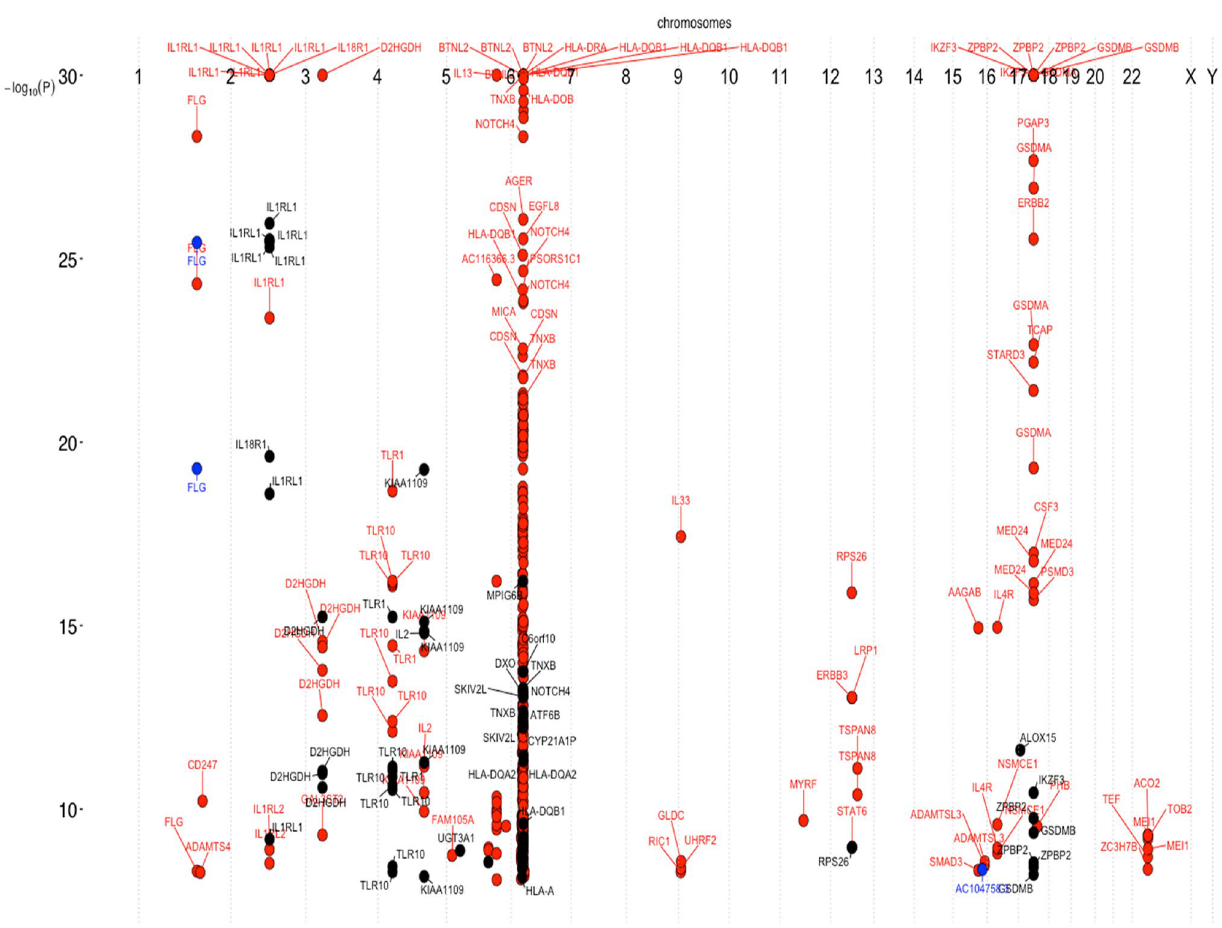
Figure 1. Exon variants of interest (N = 354) significantly associated with asthma, allergic rhinitis or atopic dermatitis in the 450 K UK Biobank samples. The plot shows significance using a threshold of P ≤ 2 × 10 –9 versus chromosomal position as Manhattan plot. Atopic dermatitis is indicated by blue dots, asthma by red dots and allergic rhinitis by black dots. Variant clustering is observed at chromosome 6 and